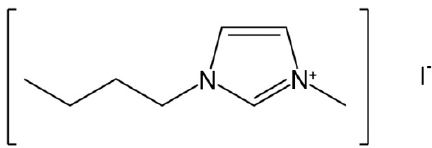
Figure 1. Structure of 1-butyl-3-methylimidazolium iodide.